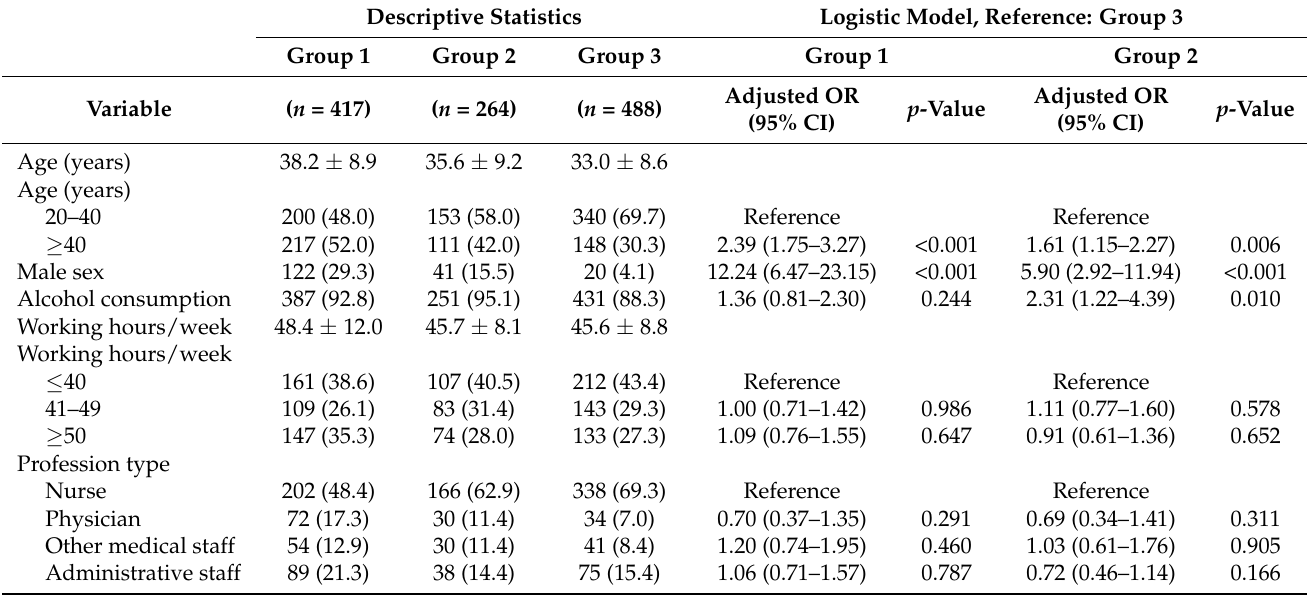
Table 1. Basic demographics of the study population according to the latent classes of developmental trajectories for MHNO in the longitudinal study.